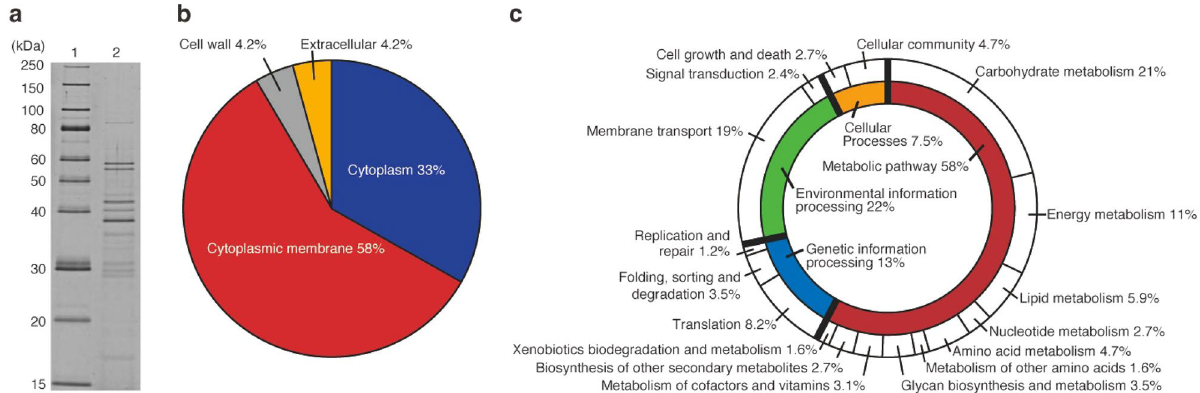
Figure 3. Proteins in L . plantarum EVs. ( a ) SDS-PAGE profile of L . plantarum EVs. Lane 1: Marker, Lane 2: L . plantarum EVs (0.3 µg). Proteins were separated by SDS-PAGE using 12.5% gel (Gellex International, Tokyo, Japan) with constant voltage at 300 V and then detected using SYPRO Ruby staining (Lonza, Rockland, ME). The cropped gel was displayed, and original gel was indicated in Supplementary Fig. 3a_original_gel file. ( b ) Subcellular localization of proteins in L . plantarum EVs. ( c ) Biological processes involving proteins in L . plantarum